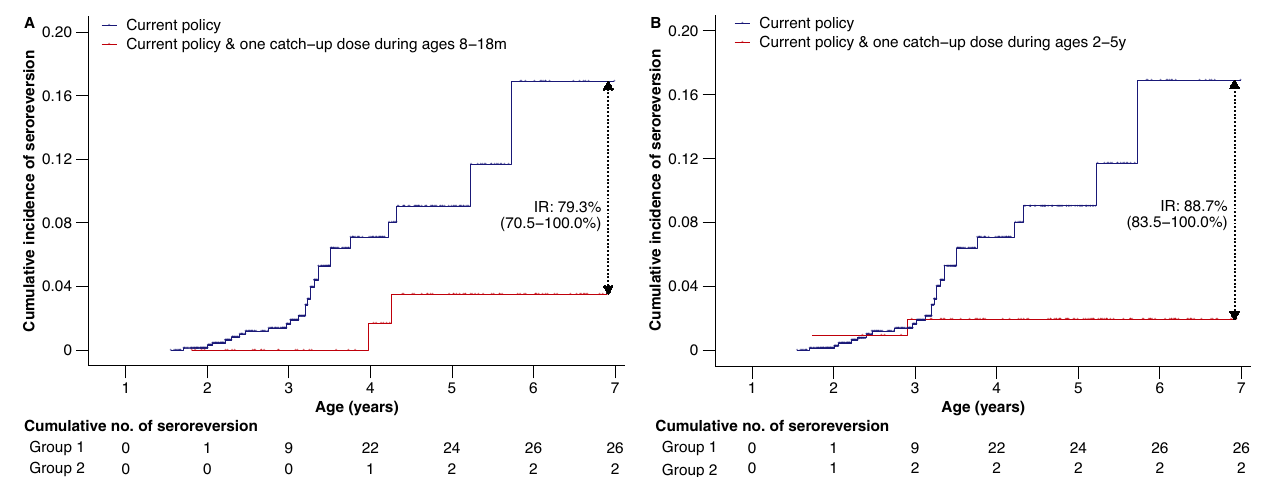
Fig. 4 | Cumulative incidence of seroreversion among children receiving the fi rstdoseofMCVat8monthsofageandsubsequentoneortwodosesbetween theages of8 months and 5 years,using a protective threshold of200mIU/ml. A Cumulativeincidenceofseroreversionamongchildrenwhoreceivedtworoutine MCV doses at 8 and 18 months of age (i.e., current policy) or received two routine MCV doses and a catch-up dose between 8 and 18 months of age. B Cumulative incidenceofseroreversionamongchildrenwhoreceivedtworoutineMCVdosesat